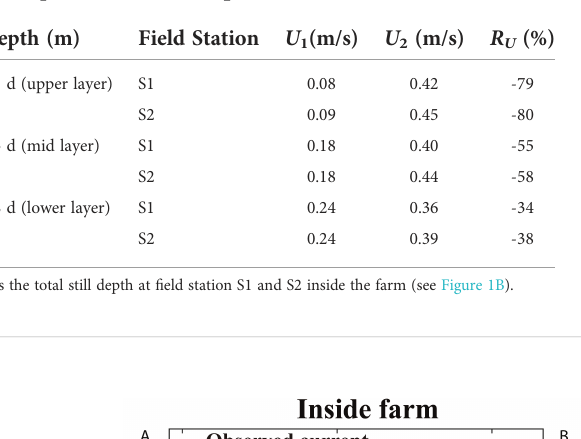
SSistheskillscore.CCisthecorrelationcoef fi cient.RMSEdenotestheroot-mean-square error. d is the local total still water depth.